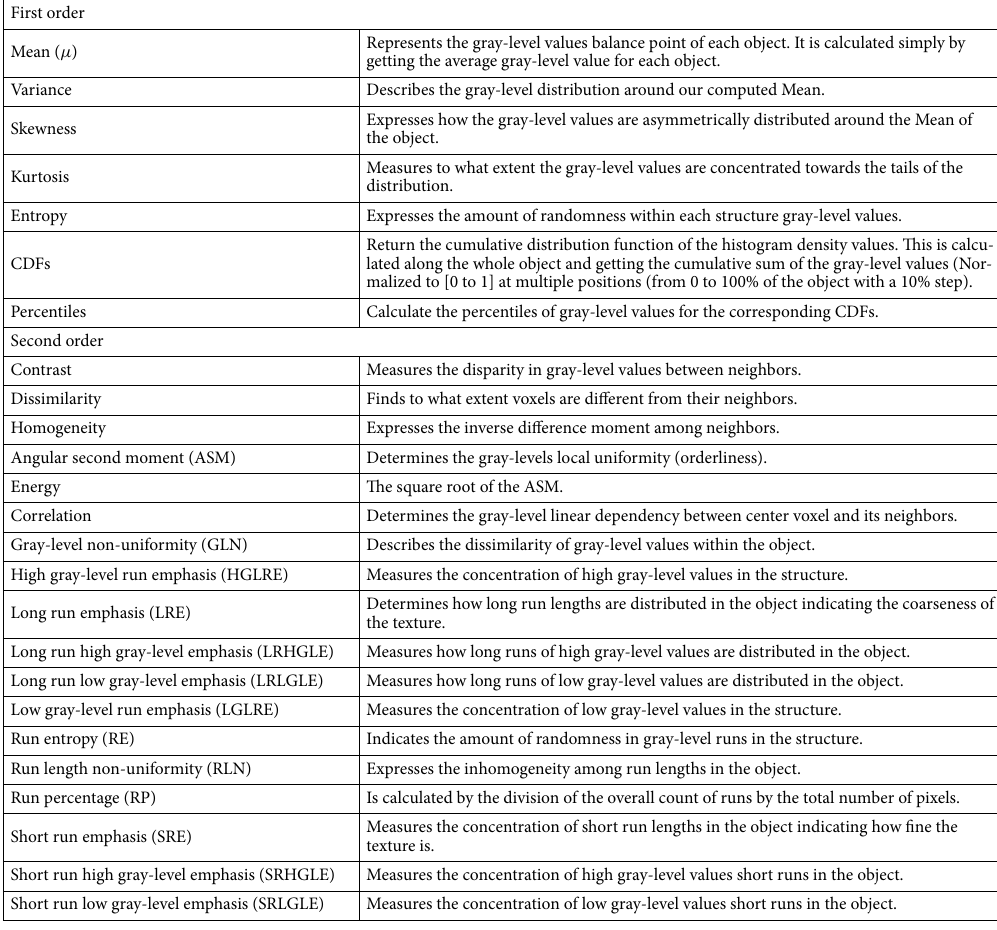
Table 2. First and second order textural